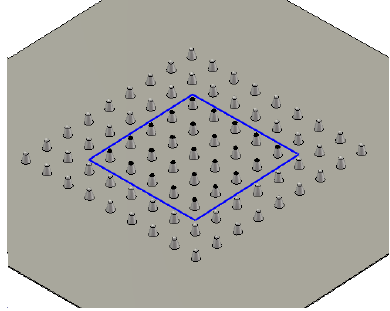
Figure 3. Simulated CNT-coated Spindt cold cathode array.